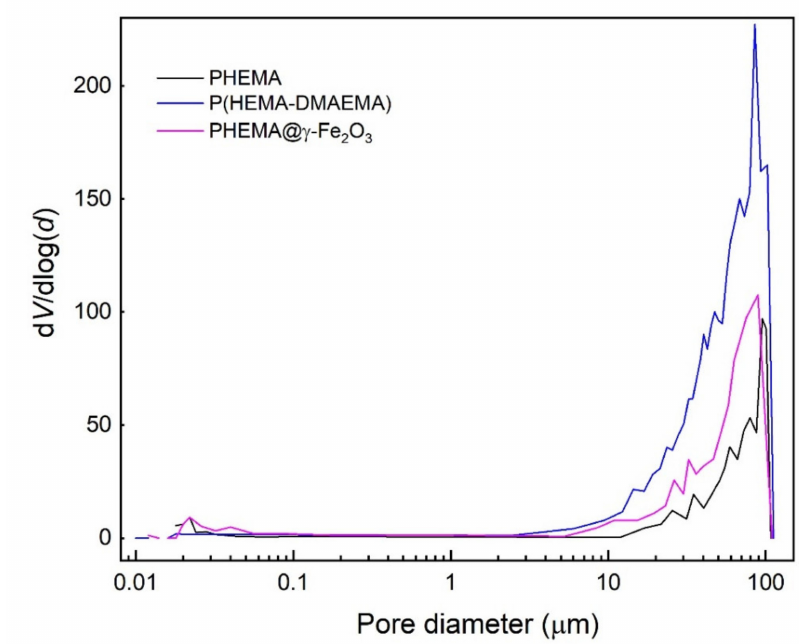
Figure 3. Pore size distribution of PHEMA, P(HEMA-DMAEMA), and PHEMA@ γ -Fe 2 O 3 hydrogels determined by mercury porosimetry; V –pore volume, d –pore